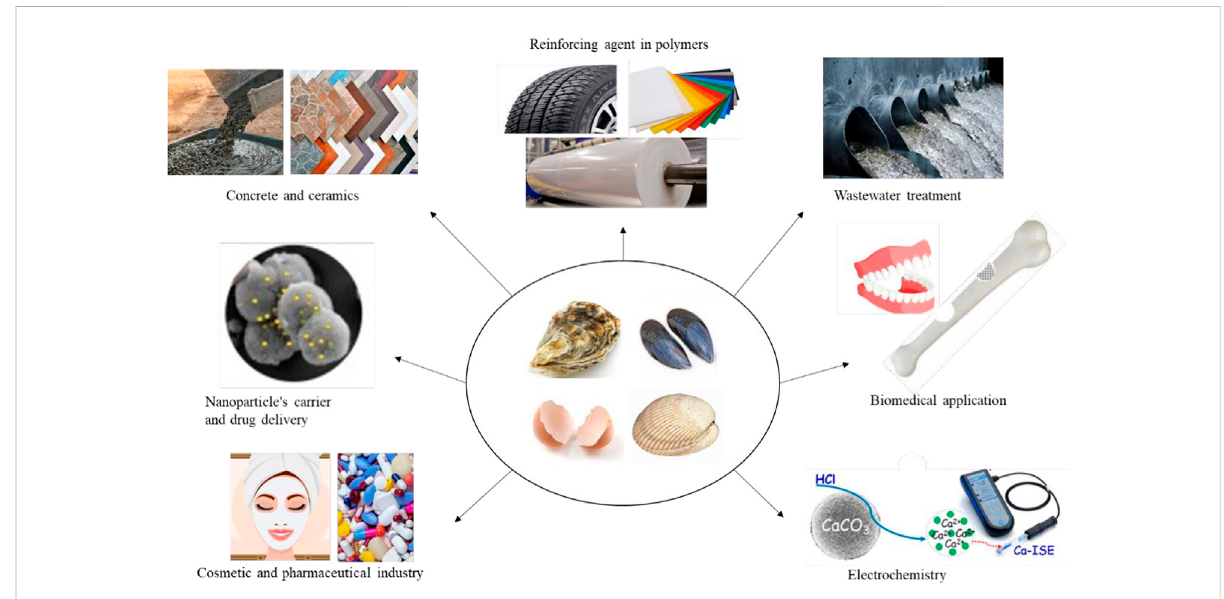
FIGURE 9 Overviewofbiogenicderivedcalciumcarbonateapplicationsfromwasteshells.AdaptedandreproducedwithpermissionfromRoyalSocietyof Chemistry, (Yu et al., 2010; Fu et al., 2017b). Reproduced with permission from Liu and Lian